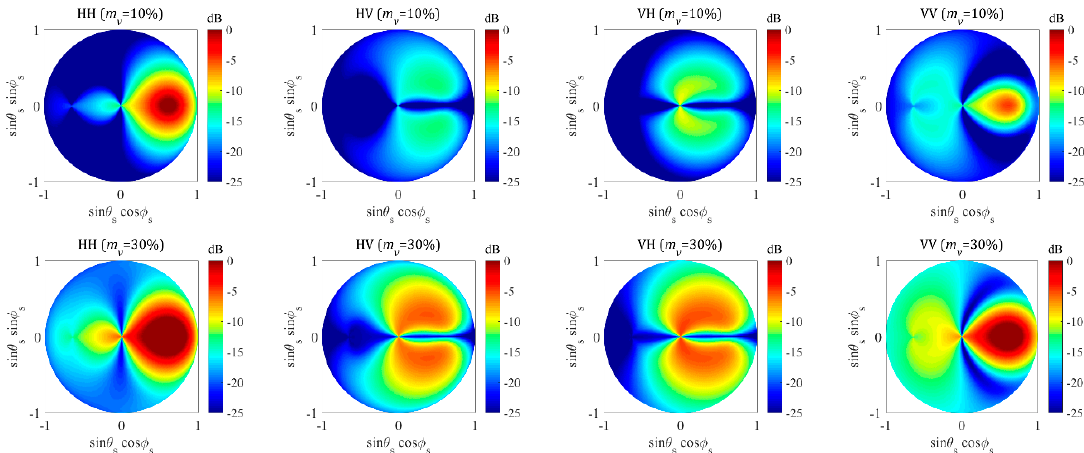
Figure 6. Hemispherical plots of polarized bistatic scattering coefficients HH, HV, VH, and VV, with